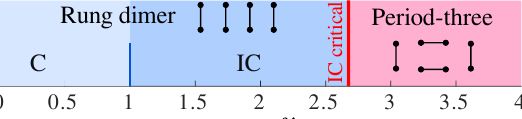
Figure 16: Phase diagram of quantum dimer model on two-leg ladder. Rung dimer phase is connected to the period-three phase via critical incommensurate phase. The width of the critical phase is smaller than the width of the red line. Short-range correlations in the rung dimer phase are commensurate before the Rokhsar-Kivelson point and incommensurate beyond.